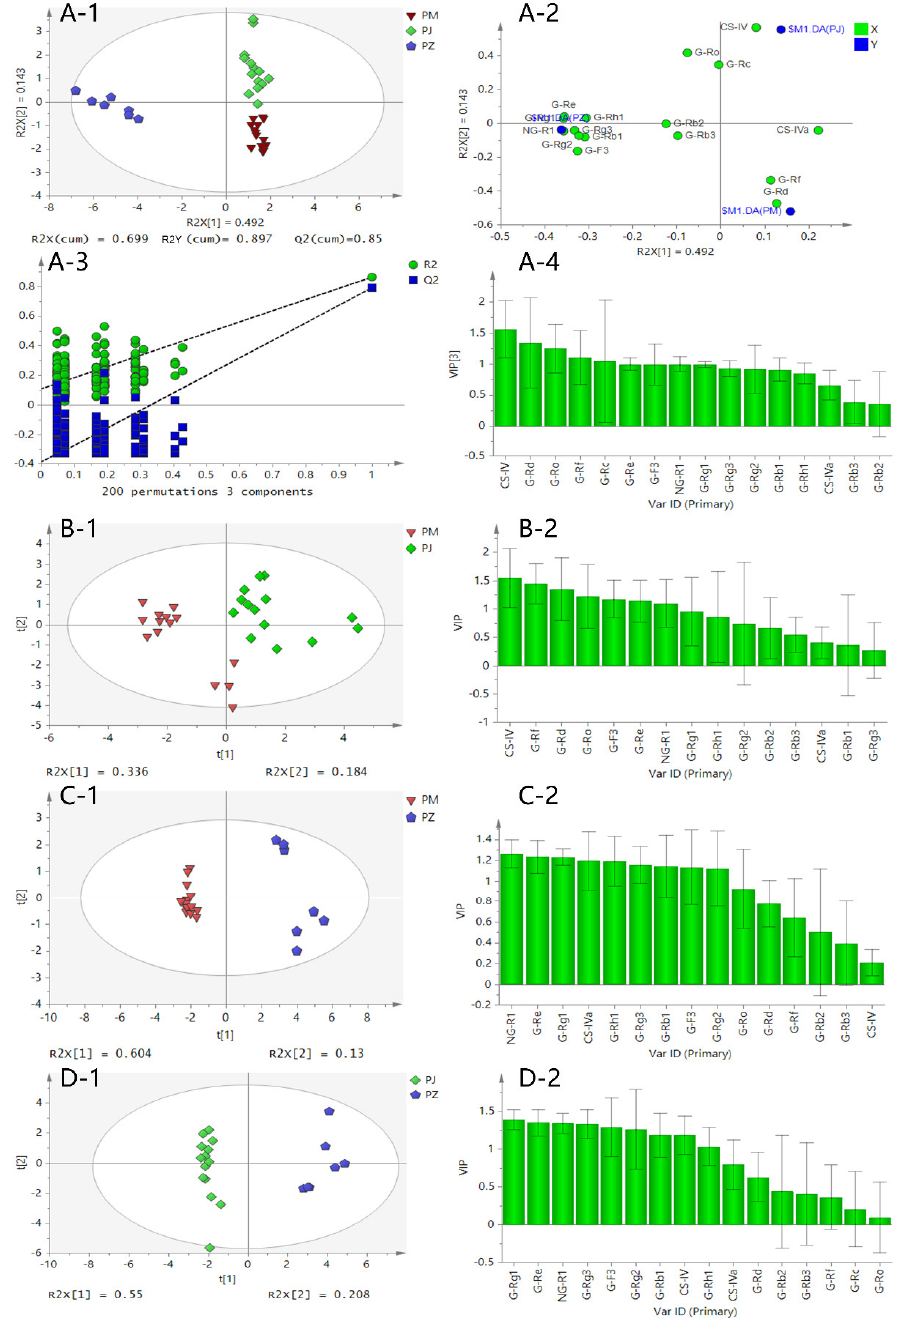
Figure 6. The PLS-DA (partial least squares–discriminate analysis) score scatter plot ( A - 1 ), the loading scatter plot ( A - 2 ), the chance permutation test to validate the occurrence or absence of over-fitting of the PLS-DA (partial least squares–discriminate analysis) model ( A - 3 ), the VIP (variable importance in the projection) values of the 16 saponins ( A - 4 ), the OPLS-DA (orthogonal partial least squares–discriminant analysis) score scatter plot based on a pairwise comparison ( B - 1 , C - 1 , D - 1 ), and the VIP values of the 16 saponins ( B - 2 , C - 2 , D - 2 ).